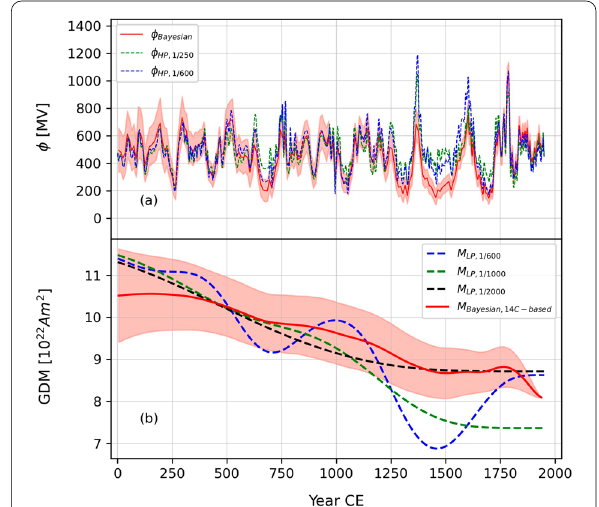
Fig. 12 A comparison between reconstruction by the Bayesian method and reconstruction by a simple frequency filter. Panel a compares solar activity reconstructed by the Bayesian method (red line) and the results using high-pass filters with cut-off frequencies of 1/250 year (green dashed line) and 1/600 year (blue dashed line), respectively. Panel b compares the GDM reconstructed by the Bayesian method (red line) and the results using low-pass filters with cut-off frequencies of 1/600 year (blue dashed line), 1/1000 year (green dashed line) and 1/2000 year (black dashed line), respectively. The light red shadings indicate the 2-sigma uncertainty envelope